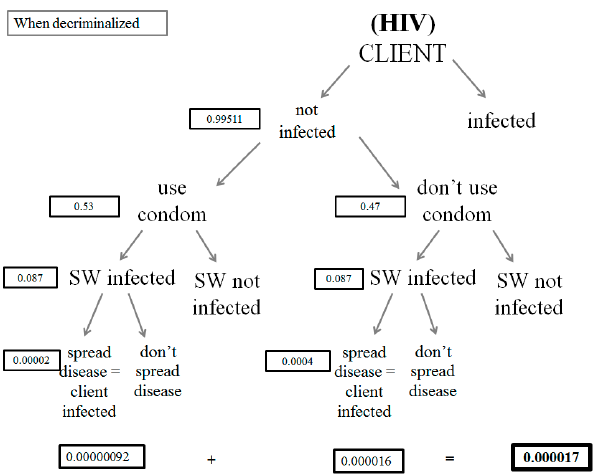
Figure A13. Risk of HIV transmission to a client under decriminalization.